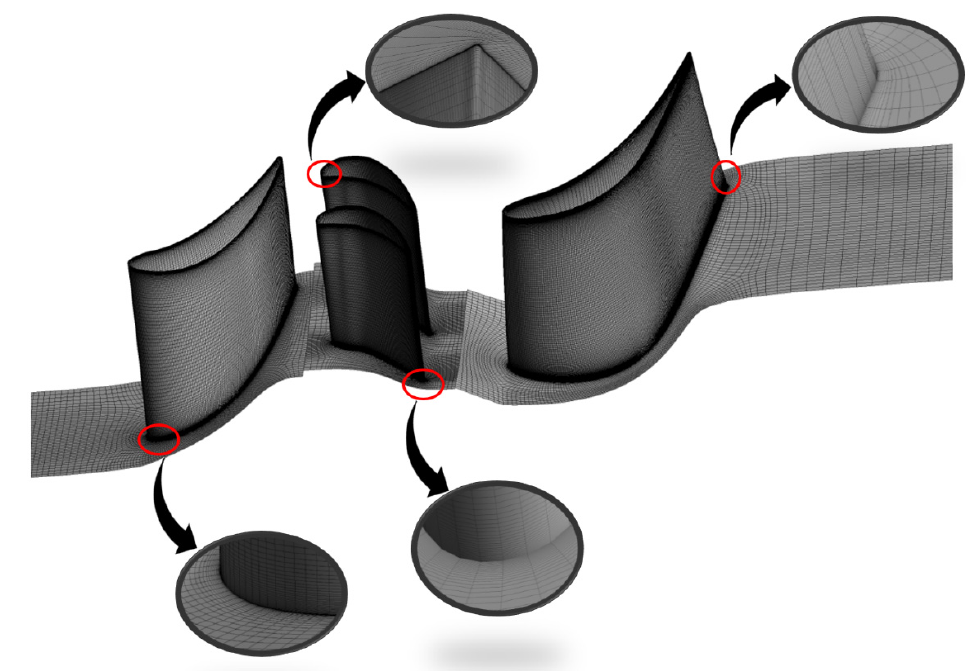
Figure 2. Detailed mesh of computational domain for the 1.5-stage GE-E3 gas turbine. Mathematics 2020 , 8 , x FOR PEER REVIEW Table 1. Grid-independent test.